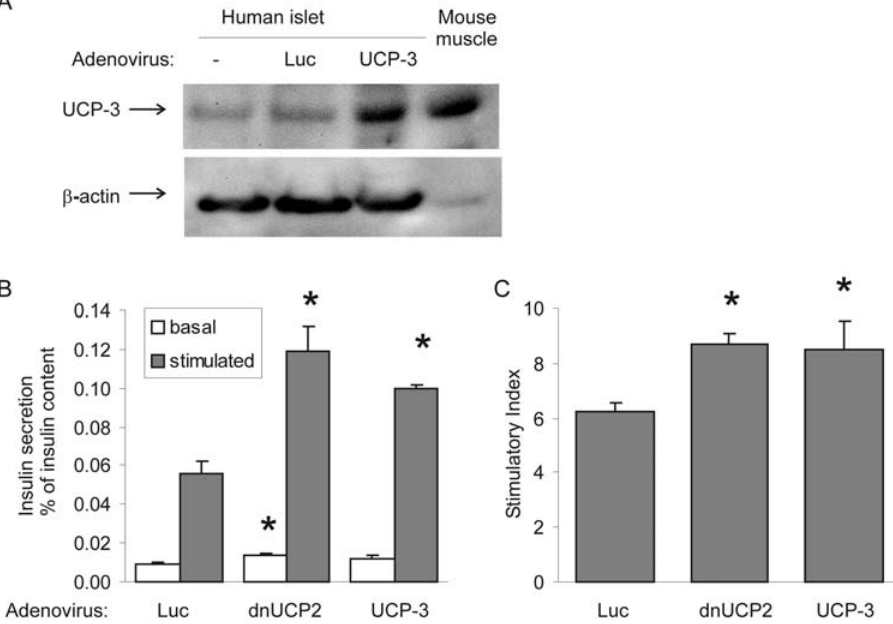
Figure 4. UCP3 over expression in human islets increases glucose-stimulated insulin secretion. A Western blot analysis of UCP-3 expression in transduced islets. B Isolated human pancreatic islets were cultured on extracellular matrix-coated dishes and transduced with adenoviruses expressing control virus (luciferase, Luc), UCP-3 or dnUCP-2. Basal and stimulated insulin secretion indicate the amount secreted during 1-hour incubations at 2.8 (basal) and 16.7 mM (stimulated) glucose following the 2-day culture period after transduction, normalized to whole islet insulin content. C Stimulatory index denotes the amount of stimulated divided by the amount of basal insulin secretion. Data represent results of two different experiments from two different organ donors in quadruplicate. Results are means 6 SE, *p , 0.05 compared to control.